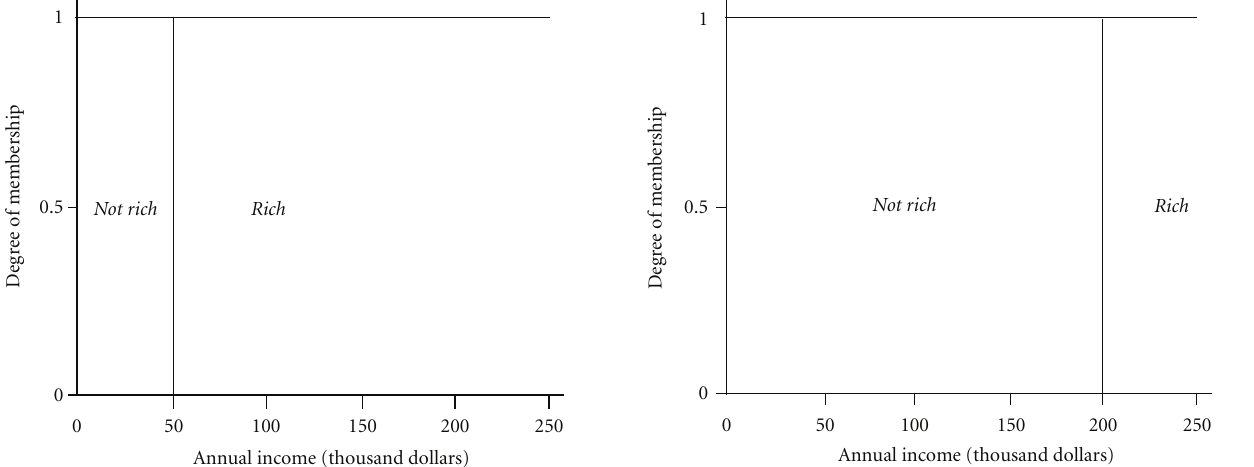
Figure 3: Warren’s crisp sets for rich and not rich with his dividing line of $200,000.